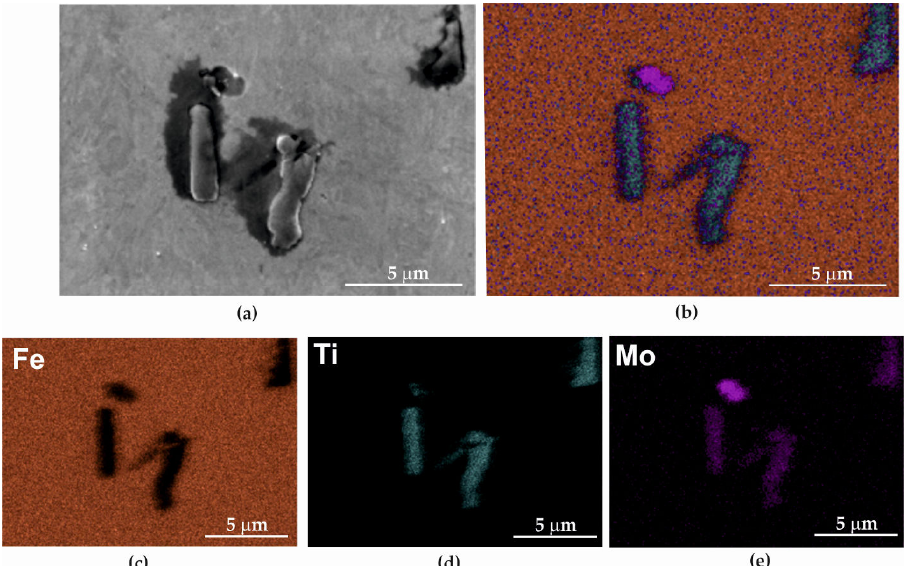
Figure 6. Metallographic examination of Armstal 550 steel: ( a ) examined surface; ( b , c ) iron; ( d ) inclusions of titanium; and ( e ) molybdenum.